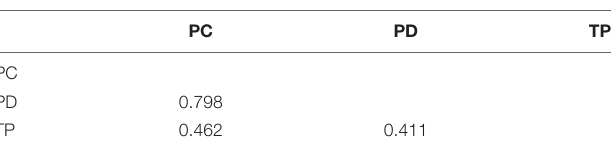
TABLE 5 | Discriminant validity (HTMT ratio).